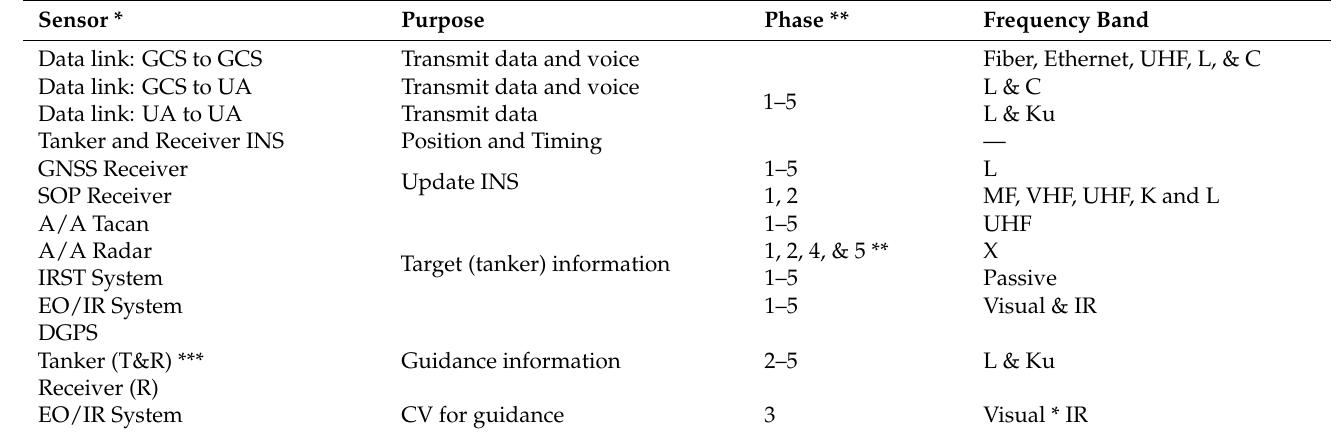
Table 1. Summary of the sensors